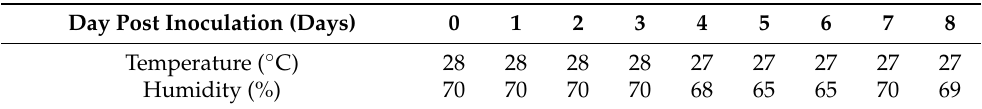
Table 1. The temperature and humidity in the biosafety facility during the viral inoculation experi-